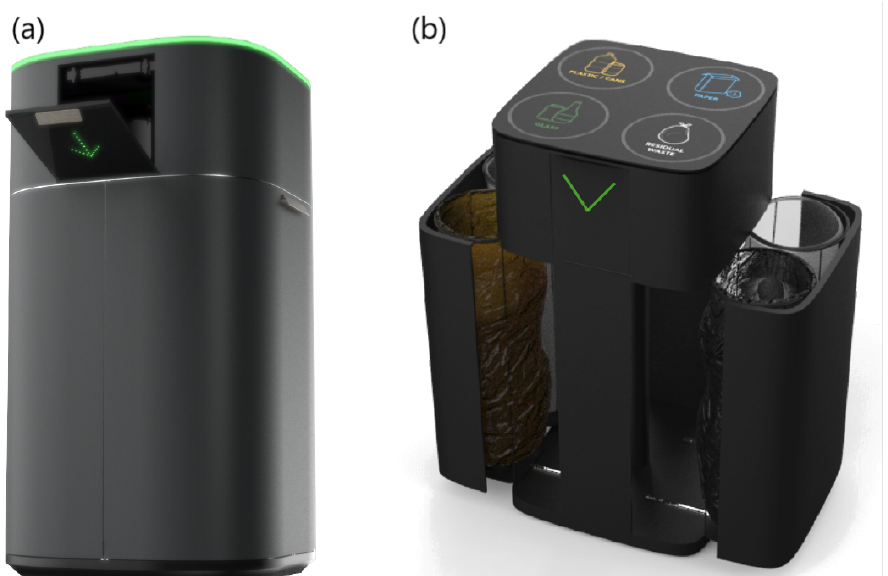
Figure 3. Three-dimensional (3D) render of the Smart Waste Bin: ( a ) on top, the lid of Waste Disposal Unit with LED feedbacks, ( b ) on the bottom, the garbage unit in its open position, showing the internal bin bags.